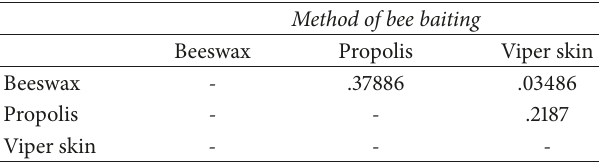
Table 6: P-value matrix for cross tabulation of method of bee